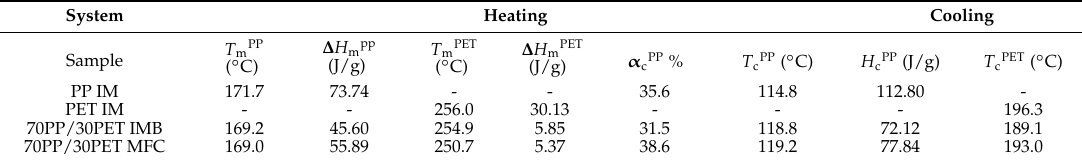
Table 2. Thermal properties of PP IM, PET IM, 70PP/30PET IMB, and MFC during the first heating and